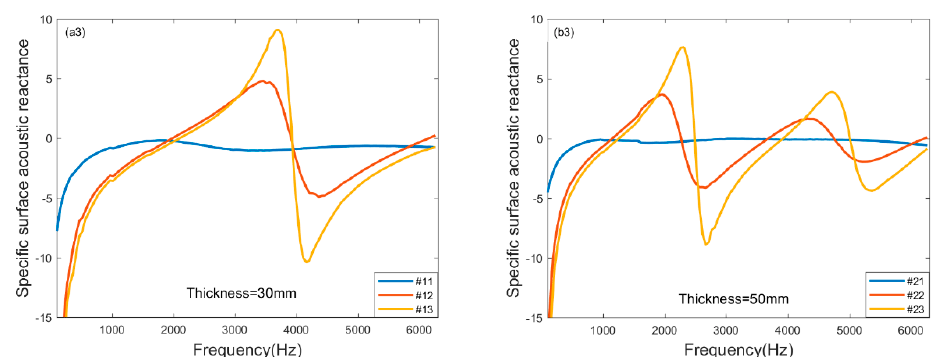
Figure 4. Sound absorption measurement of molecular sieve pellets with different pellet sizes. Sound absorption coefficients of 5Å with thickness of ( a1 ) 30 mm; ( b1 ) 50 mm; Specific surface acoustic resistance of 5Å with thickness of ( a2 ) 30 mm; ( b2 ) 50 mm; Specific surface acoustic reactance of 5Å with thickness of ( a3 ) 30 mm; ( b3 ) 50